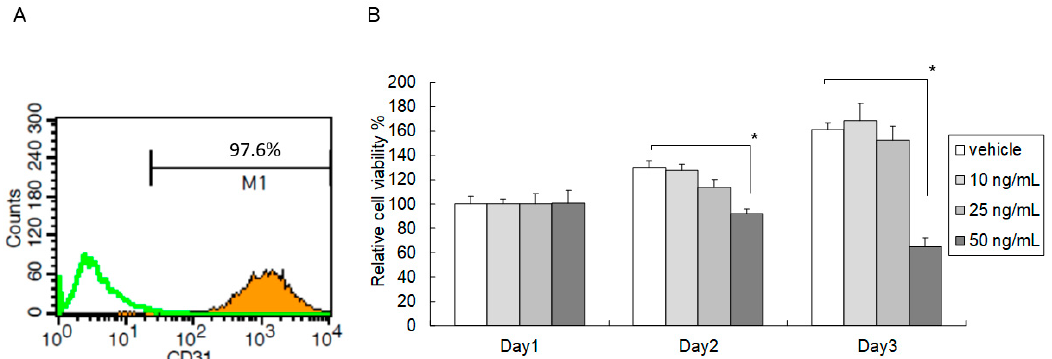
Figure 1. High-dose C5a treatment reduced mouse kidney endothelial cell (KEC) growth. ( A ) The ratio of CD31-positive cells were analyzed by flow cytometry using a FACScan and the Cell Quest software to quantify the CD31-positive cells. The white histograms were isotype controls, whereas the orange overlays were of CD31-positive cells. ( B ) Mouse KECs were treated with 0–50 ng/mL of Mouse recombinant protein C5a (rmC5a) for different periods of time. The cell viability was determined by an MTT assay. The data are presented as mean ± SD. * p < 0.05.